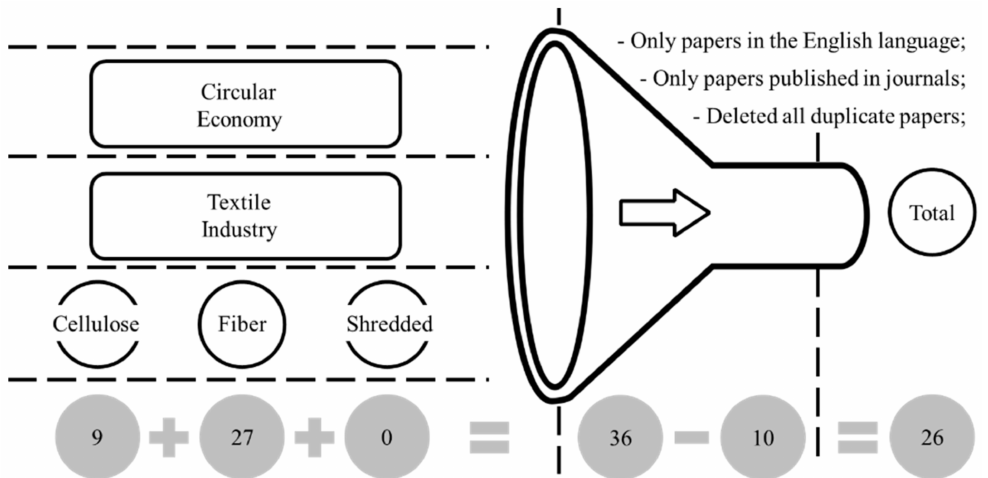
Figure 2. Protocol used for the systematic literature